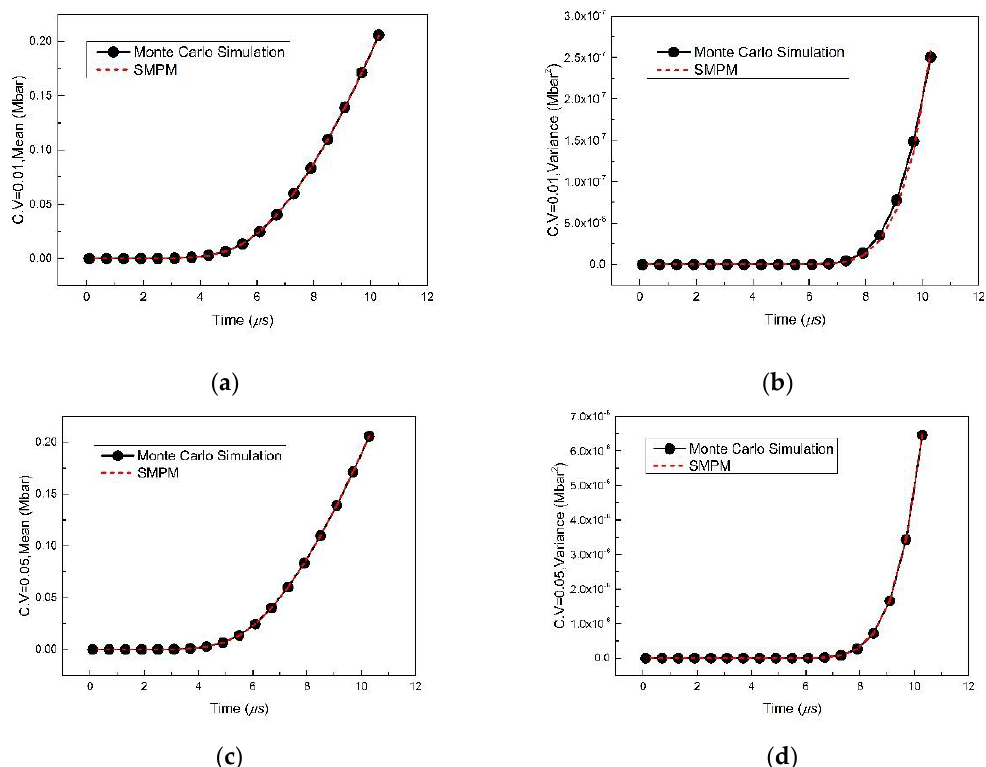
Figure 5. Pressure p ∗ response of location E by various methods with C.V = 0.01 and C.V = 0.05: Figure 5. Pressure * p response of location E by various methods with C.V = 0.01 and C.V = 0.05: ( a ) ( a ) Mean of pressure p ∗ with C.V = 0.01; ( b ) Variance of pressure p ∗ with C.V = 0.01; ( c ) Mean of Mean of pressure pressure p ∗ with C.V = 0.05; ( d ) Variance of pressure p ∗ with C.V =